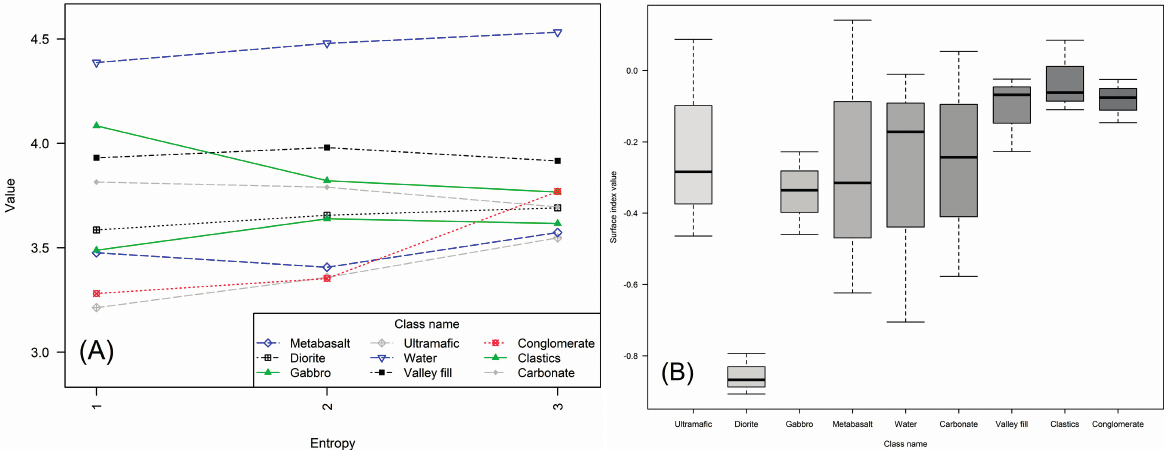
Figure 6. ( A ) Average of three texture bands for entropy measures (on bands 1, 2 and 3); ( B ) boxplot of the SI data based on the training samples for the nine discriminated